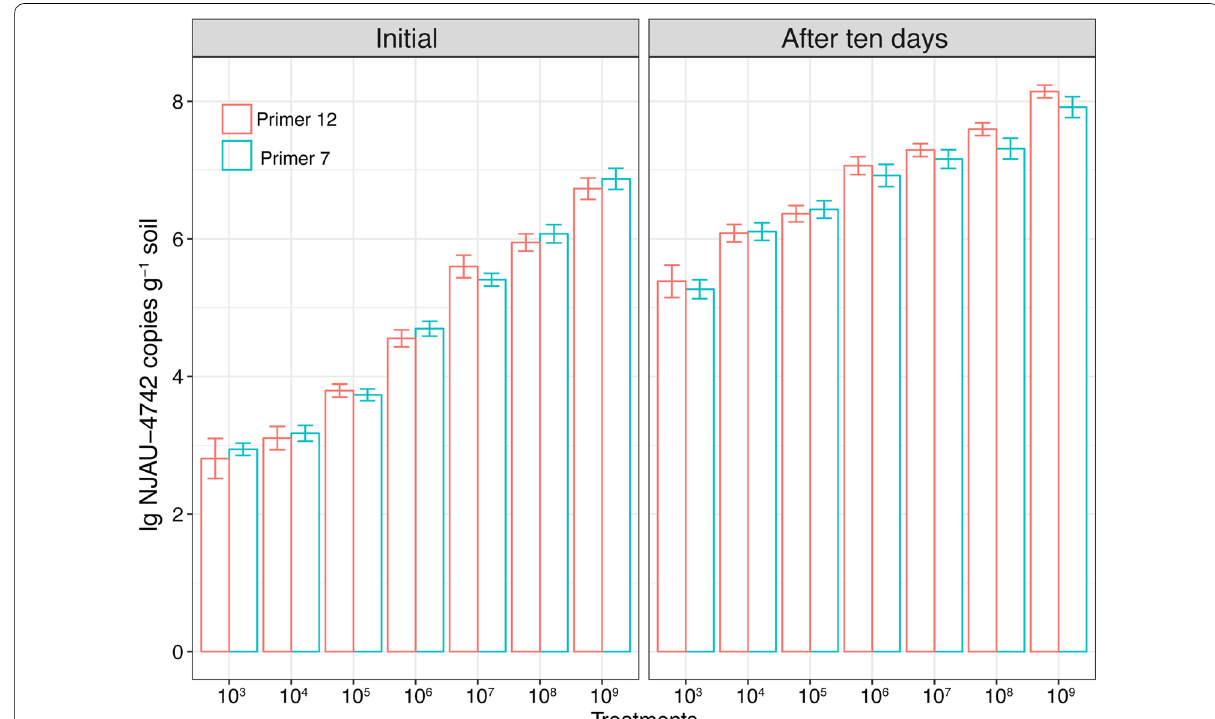
Fig. 2 Amounts of T. guizhouense gfp -NJAU 4742 detected by qPCR using the primer pairs P7 and P12 in soils amended with different inoculation concentrations. Values are the means of three soil treatment replications using different strain-specific